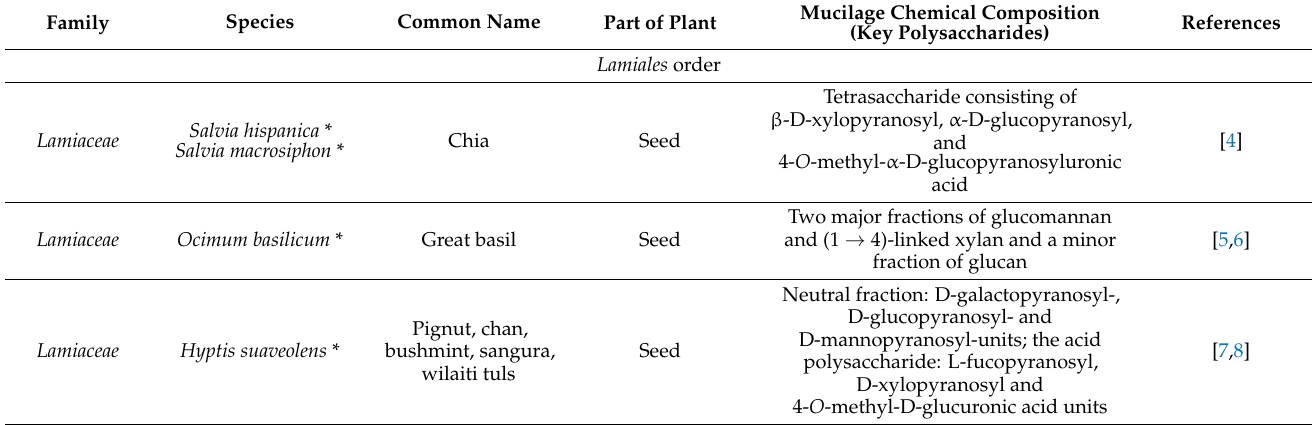
Figure 1. Seeds before and after swelling in water: ( A ) Salvia hispanica , ( B ) Plantago afra , ( C ) Linum usitatissimum , ( D ) Plantago ovata . Table 1. Sources of plant-derived mucilages.